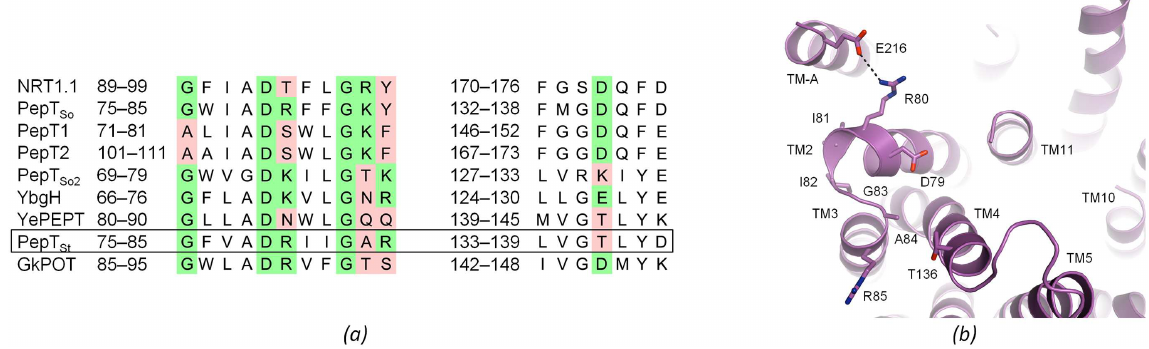
Fig 7. The A-motif. (a) Sequence alignment.Two fragmentsare shown of a sequencealignmentthat includesPepT St (boxed), the other PepTs for which structures are known, the related nitrate transporter NRT1.1 from Arabidopsisthaliana ,for which structures are also known, and humanPepT1 and PepT2. The left alignment fragment covers the A-motif in loop TM2–TM3, and the right fragment covers the regionaroundthe co-conserved acidic residuein TM4. Residuesthat match the consensussequence G-X-X-X-(D/E)-(R/K)-X-G-[X]-(R/K)-(R/K) are highlightedin green, while those that do not are highlighted in pink. (b) Structure of the A-motif and the surroundingregion, as modeledin the P3 1 21 structure of PepT St . Residuesconstituting the A-motif are labeled,and a salt bridgebetweenR80 in the A-motif and E216 in TM-A is indicatedwith